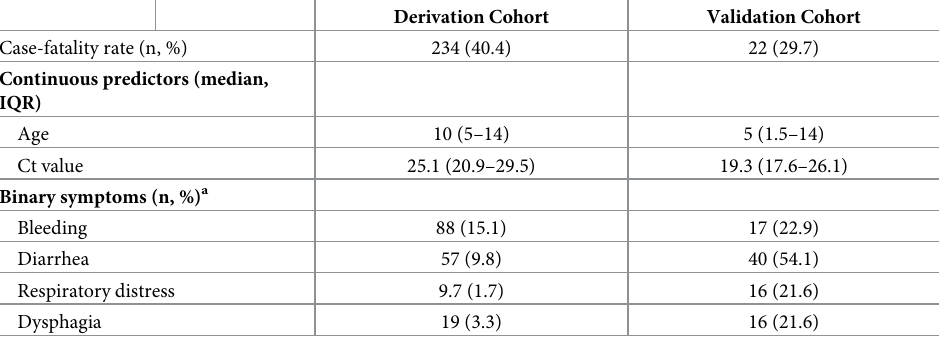
Table 2. Comparison of baseline characteristics in West Africa derivation and DRC validation